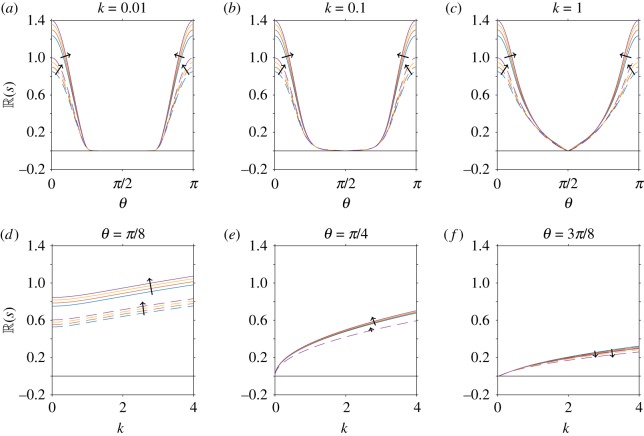
Linear stability analysis of a nearly aligned suspension, for variations in shape parameter (α0), when mechanically anisotropic effects are included but translational diffusivity is neglected. The real part of the growth rate (R(s)) for changing shape parameter α0 = 0.7, 0.8, 0.9, 1 (Γ = 2.38, 3, 4.36, infinity), where the arrow indicates the direction of increasing α0. The solid (dashed) lines indicate when transversely isotropic effects are (not) included. The Péclet number, volume fraction and stresslet strength are constant (P¯e≫1, ϕ = 0.2, α1 = − 1). The dependence of R(s) on the wave-direction θ is shown for fixed values of the wavenumber (a) k = 0.01, (b) k = 0.1, (c) k = 1, and the dependence of R(s) on k for fixed values of (d) θ = π/8, (e) θ = π/4, (f) θ = 3π/8. The black solid line in all plots indicates R(s)=0, i.e. the boundary between instability and stability.